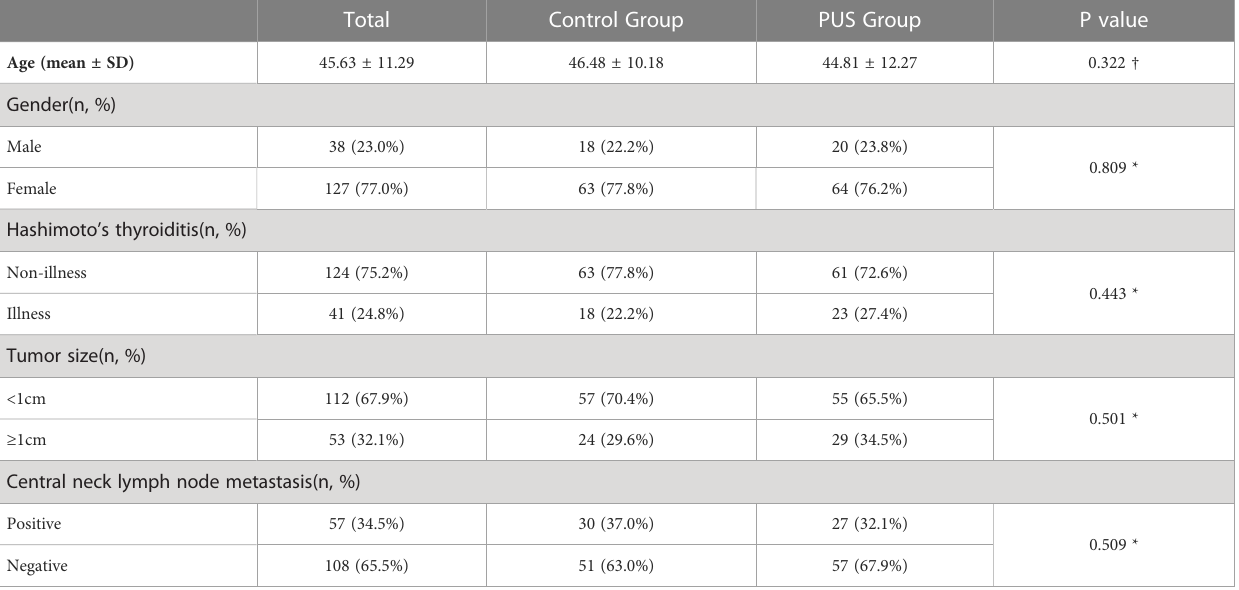
TABLE 1 Clinical data of patients with thyroid cancer included in this study.